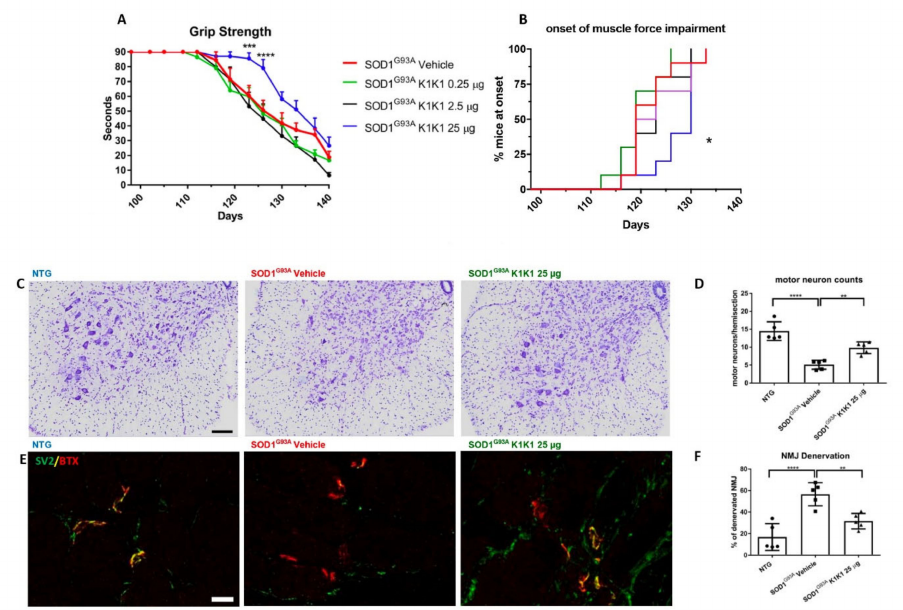
Figure 2. K1K1 25 µ g delays neuromuscular impairment and protects the neuromuscular system in SOD1G93A mice. ( A ) A significant improvement in the grip strength test performance is observed in SOD1G93A mice treated intraperitoneally (IP) with K1K1 25 µ g but not with lower dosages (0.25 and 2.5 µ g) compared to vehicle treated mice. Each point represents the mean ± SEM ( n = 10). Data were analyzed using Two-way ANOVA for repeated measures (time) and di ff erent groups (treatment). ( B ) A Kaplan–Meier curve showed that the onset of motor symptoms was significantly delayed. Data were analyzed using the Log-rank test ( p < 0.05, n = 10 animals for each group). ( C ) Representative images of Nissl staining performed on lumbar spinal cord (LSC) sections from non-transgenic (NTG) and SOD1G93A mice treated with phosphate bu ff er saline (PBS) (vehicle) or K1K1 25 µ g at the symptomatic stage of the disease (140 days). Scale bar: 100 µ m. ( D ) Quantification of the motor neuron number (cell body area > 400 µ m 2 ) in lumbar spinal cord. MNs were decreased in transgenic groups compared to NTG and 25 µ g K1K1 displayed significant neuroprotection with a partial reduction in motor neuron loss. ( E ) Representative confocal images of synaptic vesicle protein 2 (SV2, green) and bungarotoxin (BTX, red) co-localization in neuromuscular junctions (NMJs) of Tibialis Anterior Muscle (TAM) from NTG and SOD1G93A mice treated with vehicle or K1K1 25 µ g (140 days of age). Scale bar: 50 µ m. ( F ) Denervated NMJs represented by the lack of co-localization between SV2 and BTX was higher in TAM of transgenic mice treated with vehicle and K1K1 25 µ g significantly reduced this e ff ect. ( D , F ) Data are expressed as mean ± SEM, n = 5 animals per group. Data were analyzed by One-way ANOVA followed by post hoc Fisher’s least significant di ff erence (LSD). * p < 0.05, ** p < 0.01, *** p < 0.005, **** p <